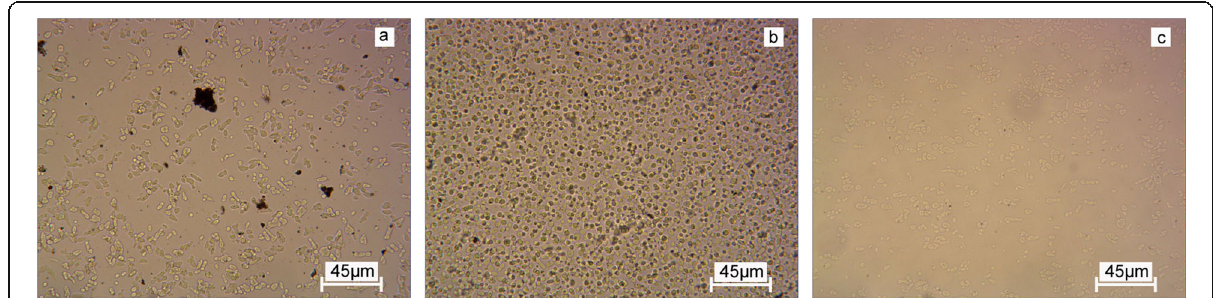
Fig. 3 The morphology of microcapsules at different pH values with the gelatin/CMC ratio of 7:1. a pH= 4.51, b pH= 4.64, c pH= 4.78. When the ratio of gelatin/CMC was 7:1, at pH 4.64, spherical capsules can be produced with uniform particle size; however, the sparse distribution of microcapsule indicates a low yield